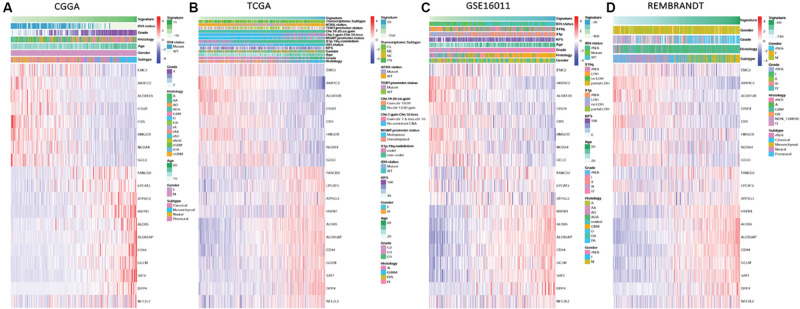
Ferroptosis-related genes expression profiles and correlation between signature risk score, gene expression and clinical or molecular pathological features in CGGA, TCGA, GSE16011, and REMBRANDT datasets. (A–D) Heatmaps show the different expression levels of 19 ferroptosis-related genes horizontally clustered in the CGGA dataset and clinical or molecular pathological features ranked by risk score of the signature of 19 ferroptosis-related genes in CGGA (A), TCGA (B), GSE16011 (C), and REMBRANDT (D) datasets. Chinese Glioma Genome Atlas (CGGA); The Cancer Genome Atlas (TCGA); The Repository of Molecular Brain Neoplasia Data (REMBRANDT); isocitrate dehydrogenase (IDH); methylguanine methyltransferase (MGMT); Karnofsky Performance Status (KPS); classical (CL), mesenchymal (MES), neural (NE), and proneural (PN); alpha thalassemia/mental retardation syndrome X-linked (ATRX); telomerase reverse transcriptase (TERT); chromosome (Chr); wild type (WT); codeletion (codel); female (F); male (M); grade (G); astrocytoma (A); oligodendroglioma (O); oligoastrocytoma (OA); anaplastic astrocytoma (AA); anaplastic oligodendroglioma (AO); anaplastic oligodendroglioma (AOA); pilocytic astrocytoma, (PA); glioblastoma multiforme (GBM); loss of heterozygosity (LOH).